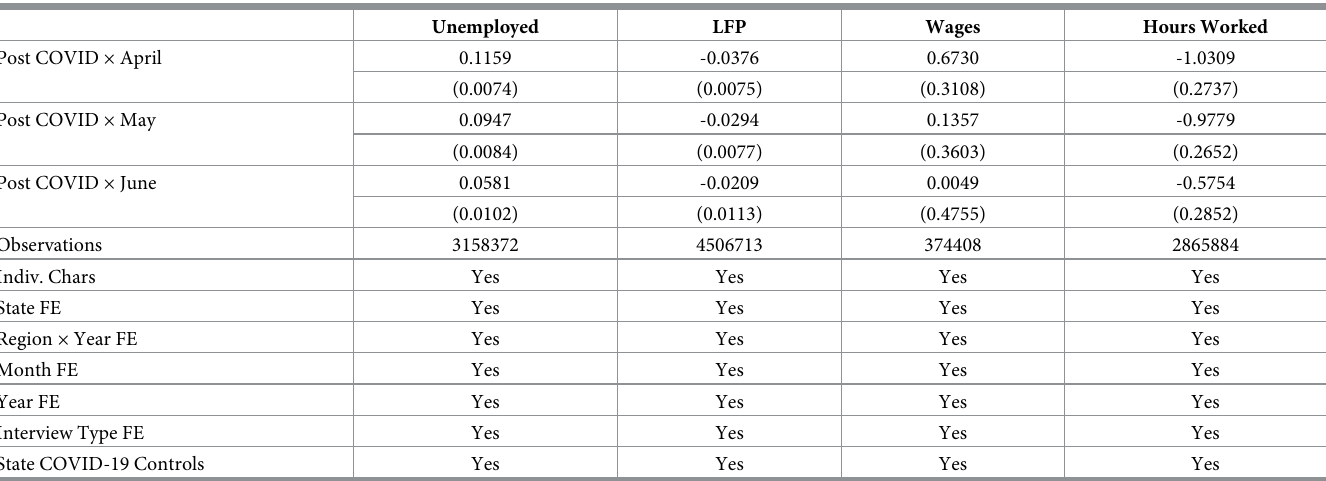
Table 7. The impacts of COVID-19: